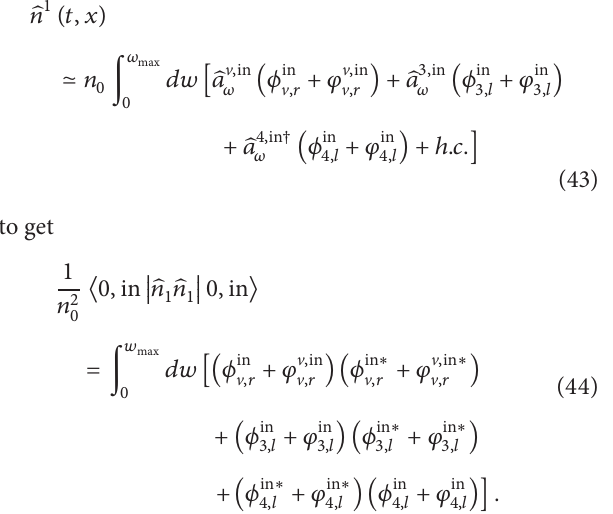
𝑐 )𝑒 𝑖(𝑐 fin −𝑐 𝑟 )𝑘 󸀠 𝑡 0 , 𝛽 󸀠 = ((𝑐 𝑟 fin